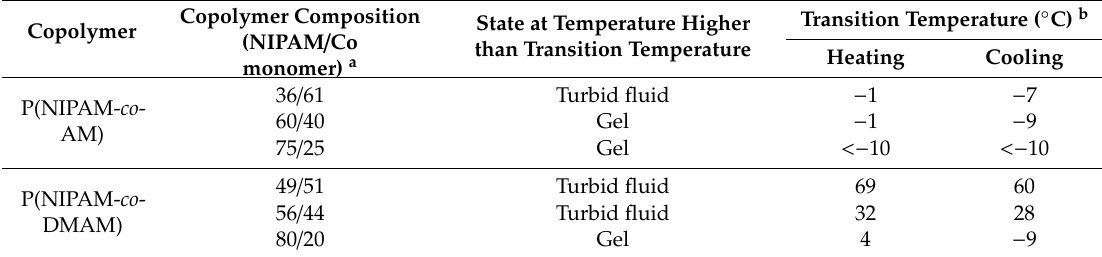
Table 3. Gelation and phase transition behaviors of P(NIPAM- co -AM) and P(NIPAM- co -DMAM) in 35wt% hydrazine aqueous solution.